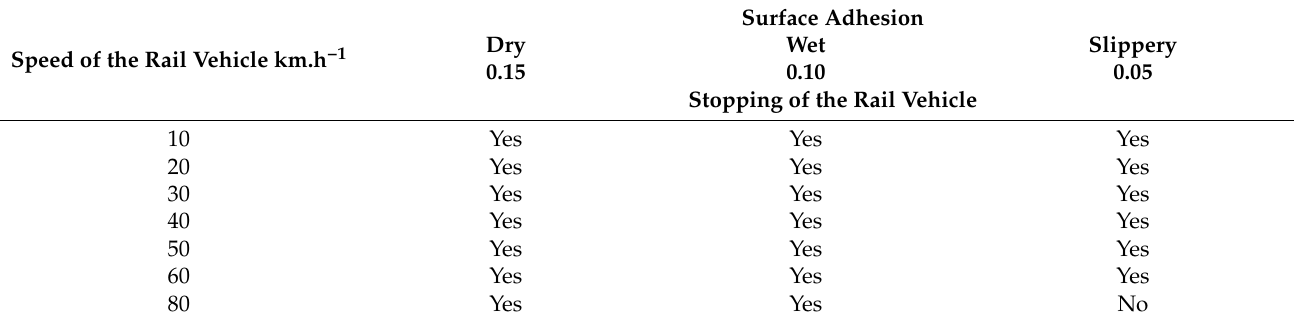
Table 8. Possibilities of avoiding collisions at crossing P5967 in the direction of ˇCesk é Budˇejovice.